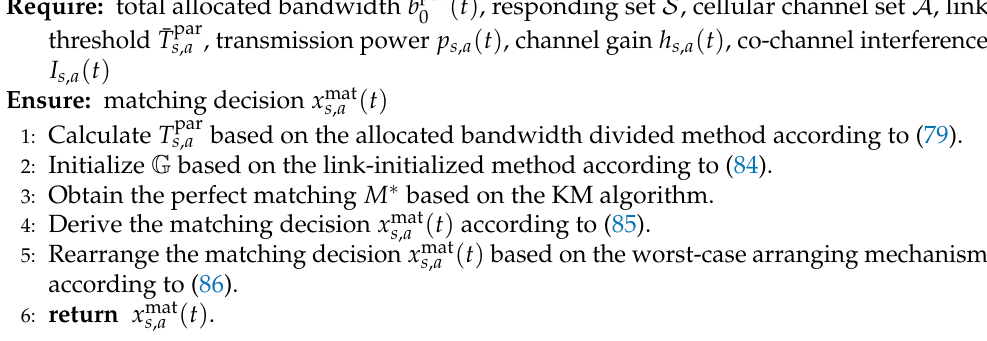
Algorithm 3 KM algorithm-based channel-division fetching module